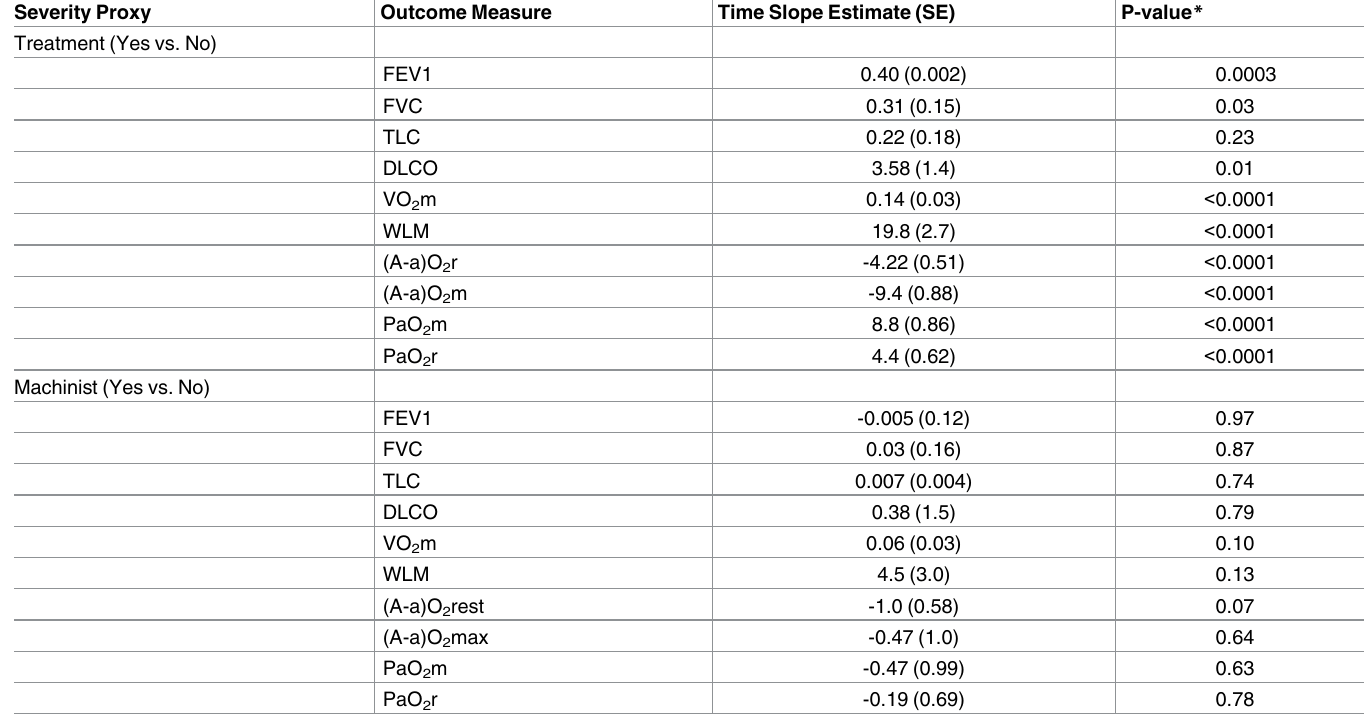
Table 6. Longitudinal models of lung function and current